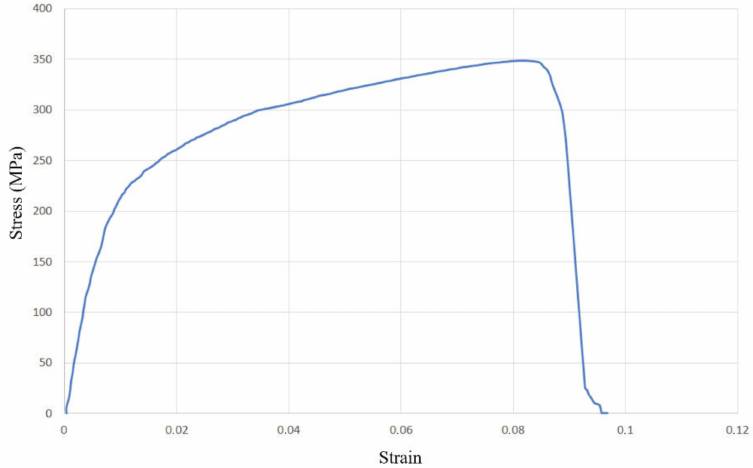
Figure 16. Stress–strain diagram for the group with misalignment, undercut, and incomplete root penetration (group